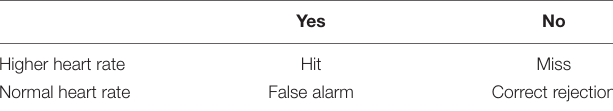
TABLE 1 | Summary of type 1 responses based on participants’ answers to the question “Is your heart beating faster than usual?”(yes/no answer) and whether their heart rate was detected as higher than